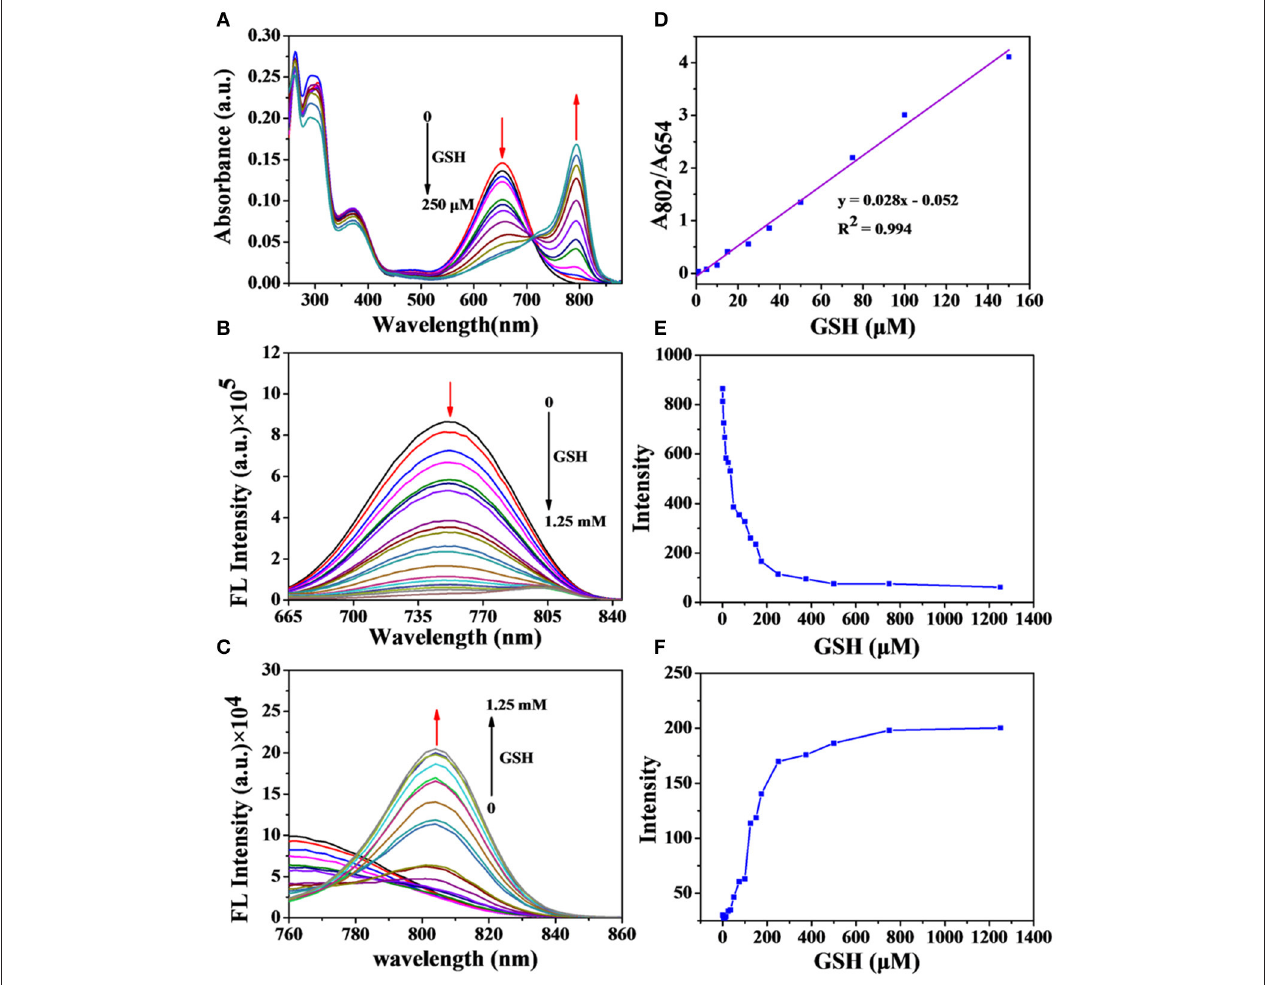
FIGURE 2 | (A) UV-Vis absorption changes of Cy-SS-MTX (5 µ M) in the presence of GSH in the DMSO/PBS (1/1, v/v, PH = 7.4). Fluorescence spectra responses of Cy-SS-MTX (5 µ M) to GSH ( λ ex = 640 nm/ λ em = 750nm (B) , λ ex = 745 nm/ λ em = 808nm (C) . (D) The rate value of absorption of Cy-SS-MTX in 802 and